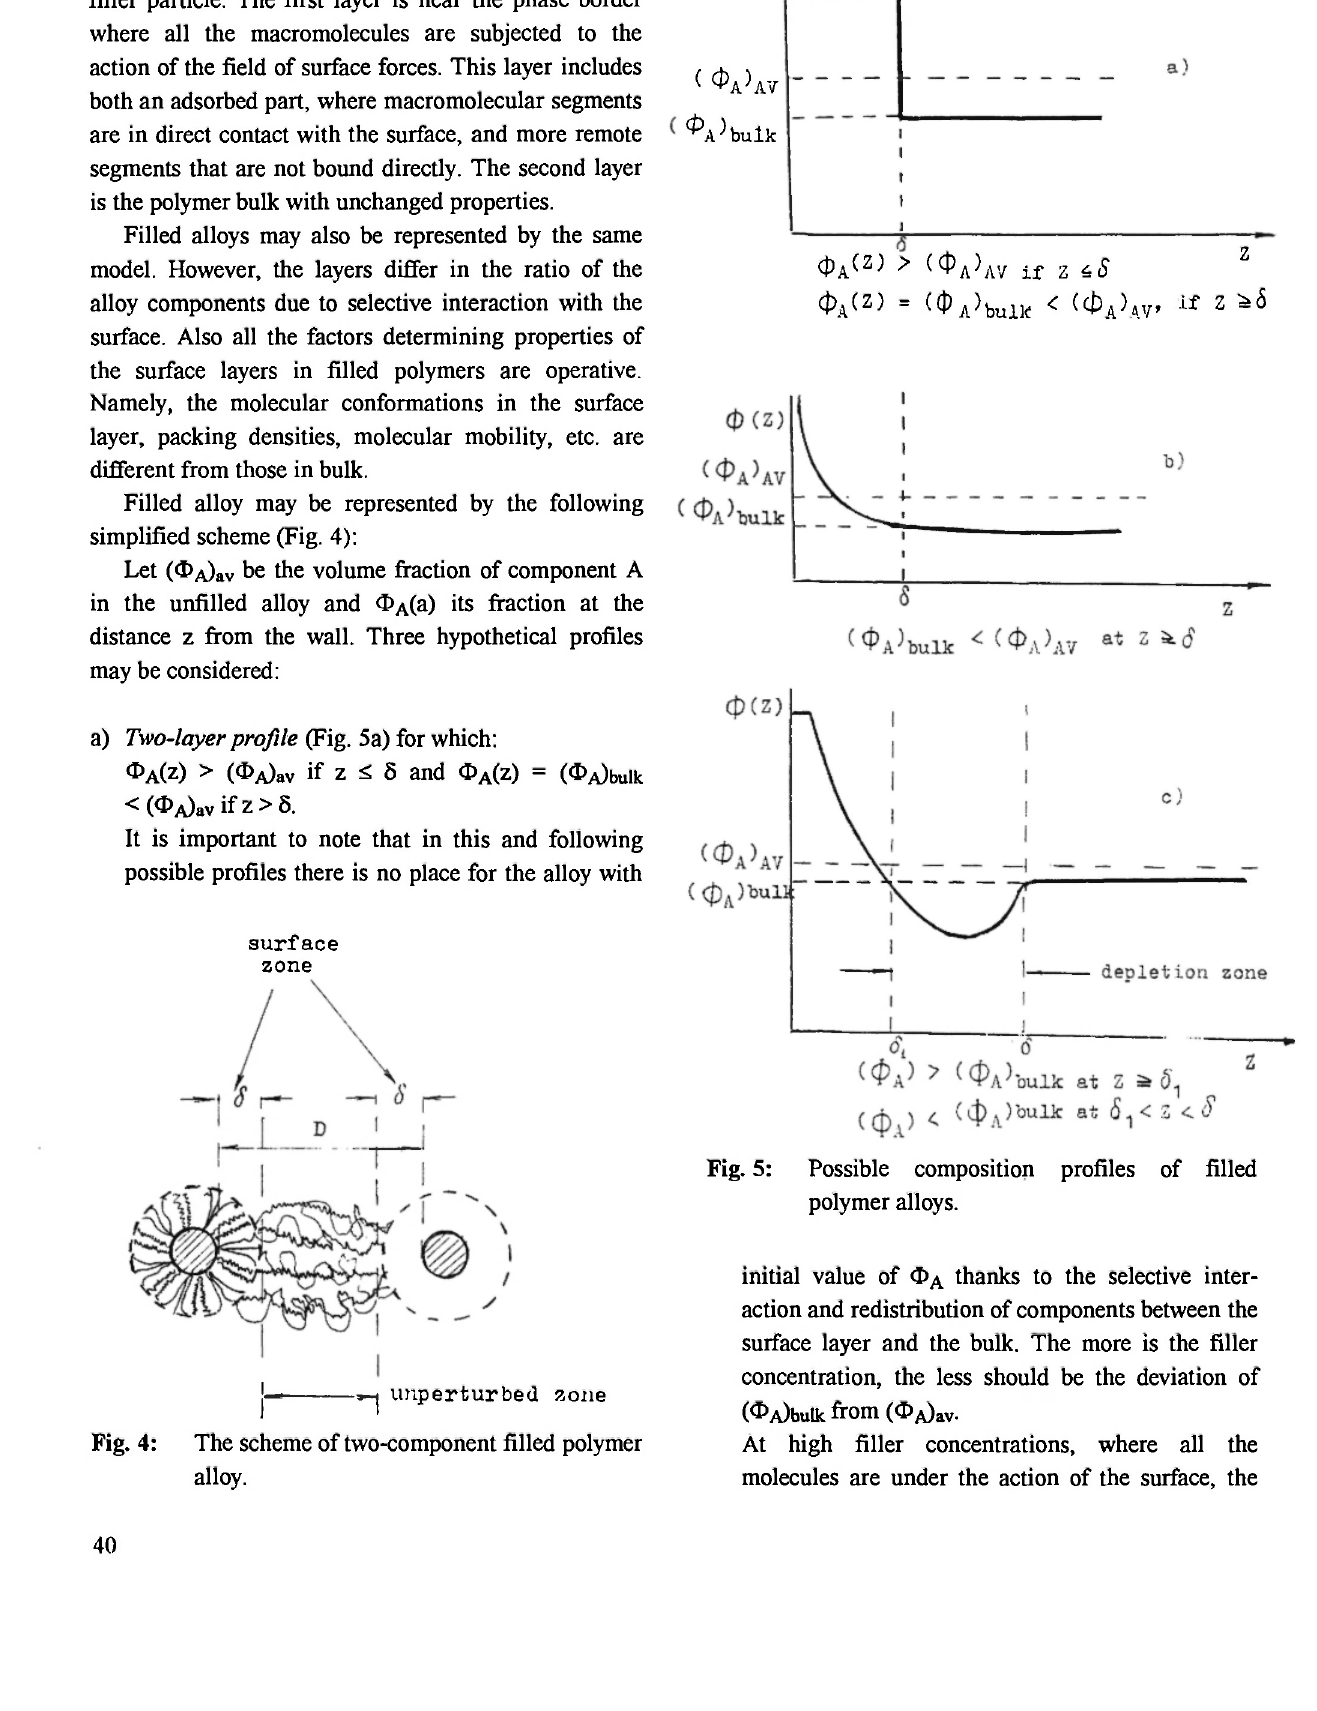
Fig. 4: The scheme of two-component filled polymer alloy.